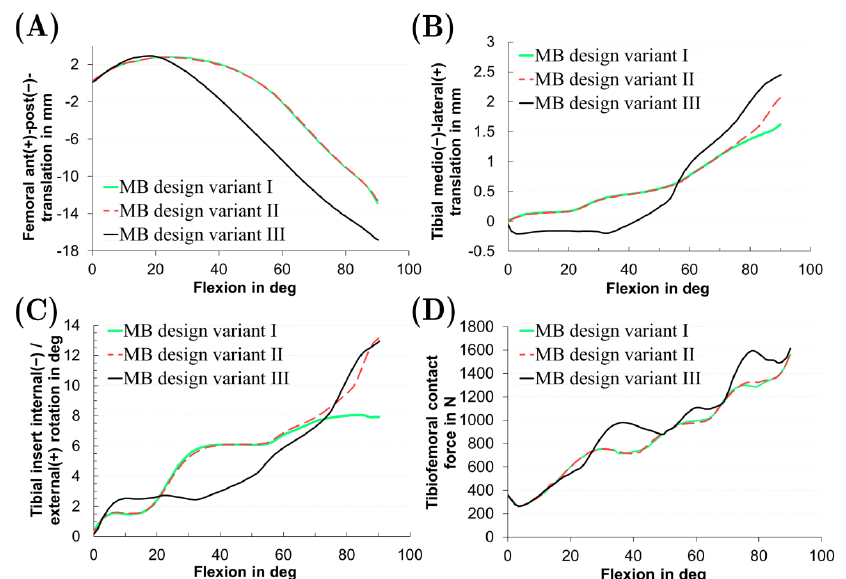
Figure 5. Tibiofemoral kinematics and kinetics during the dynamic squat motion for the three mobile-bearing (MB) total knee replacements (MB design variants I, II, and III). Evaluation of the femoral anterior(+)-posterior( − ) translation ( A ), tibial medio( − )-lateral(+) translation ( B ), tibial insert rotation with respect to the tibial tray ( C ), and tibiofemoral contact force ( D ).